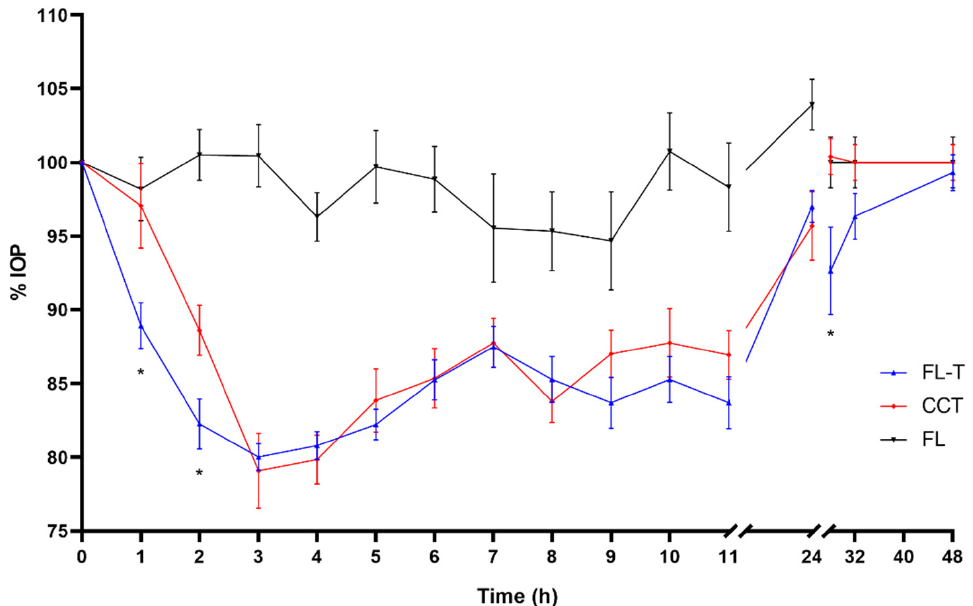
Figure 9. Decrease in intraocular pressure after administration of the liposomal formulation containing travoprost (0–48 h), with statistical significance between CCT and FL-T formulations (* p < 0.05).